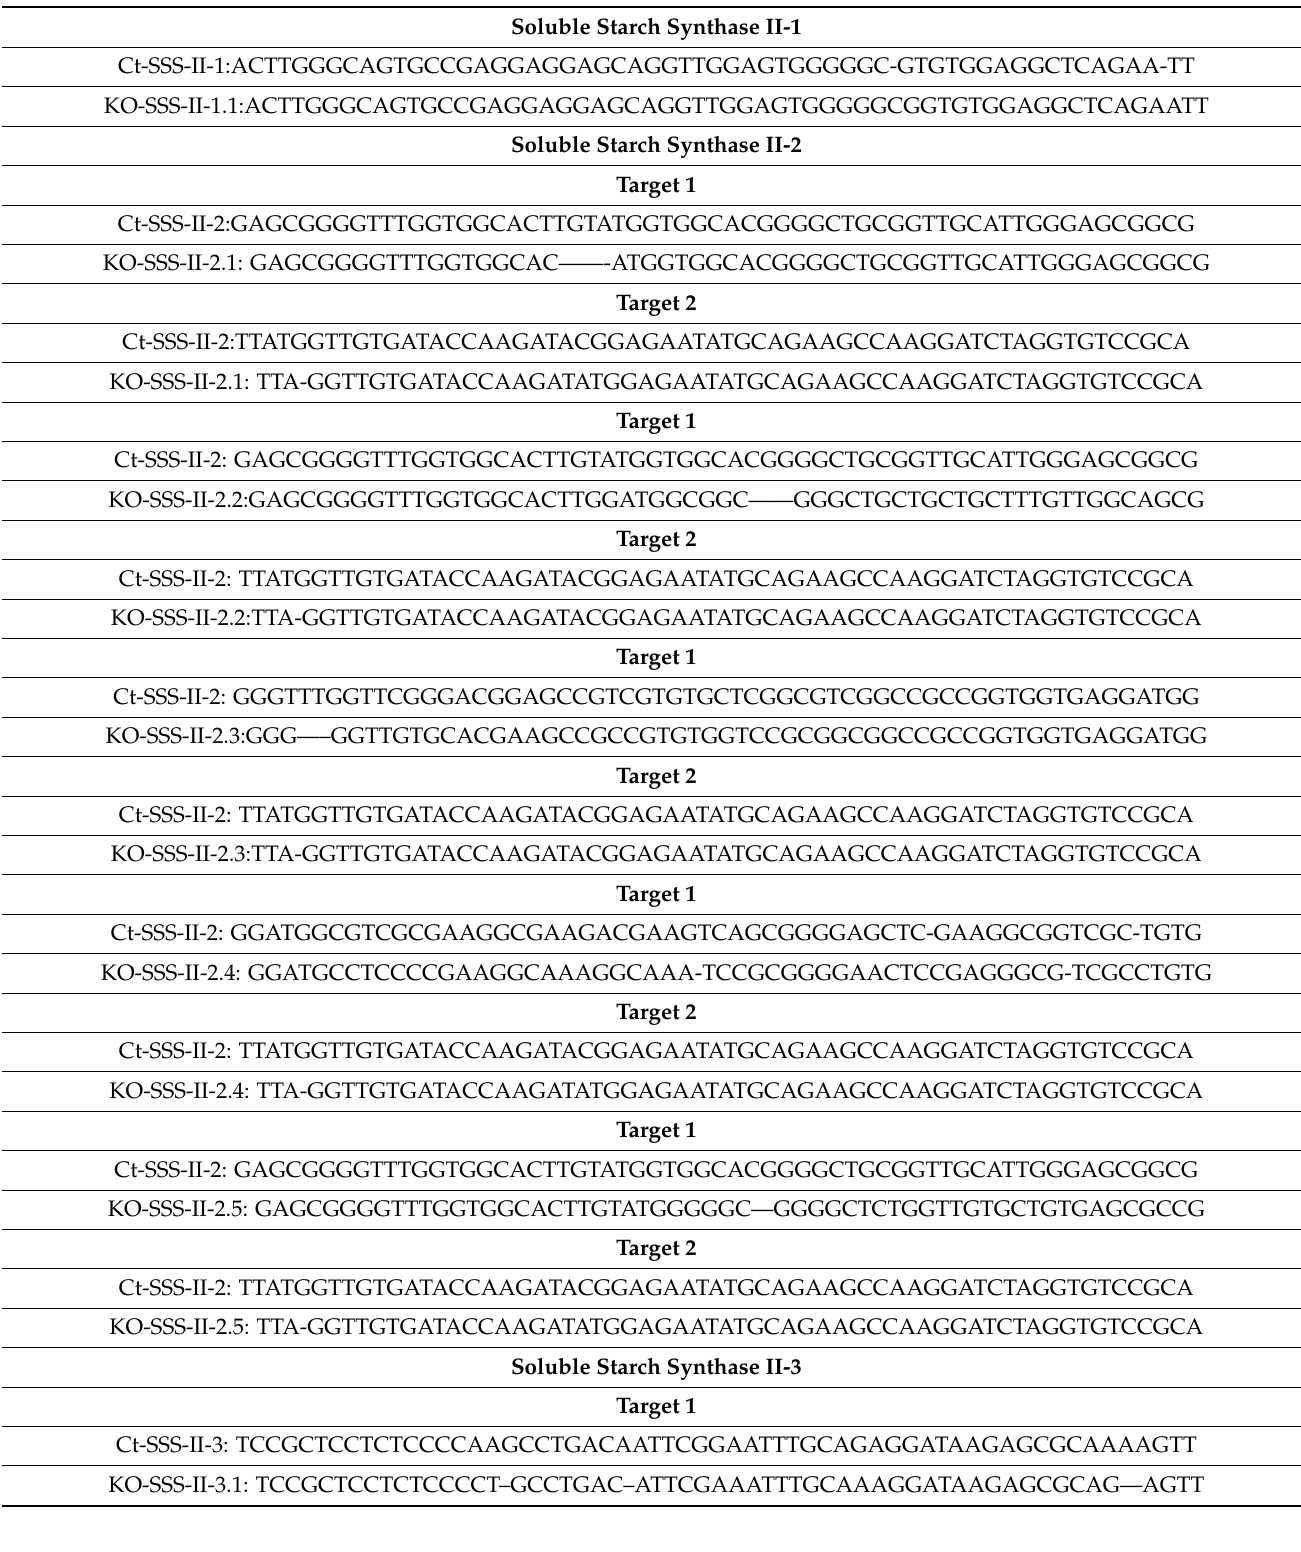
Table 2. Sequencing analysis for Cas9-free plant lines mutated (knocked out—KO) at SSII-1, SSII-2, and SSII-3 genes. The results of sequencing of SSSII-1, SSSII-2, and SSSII-3 mutant lines. The sequences in yellow are target nucleotide sequences, deletions are shown in dashes, and red nucleotides are